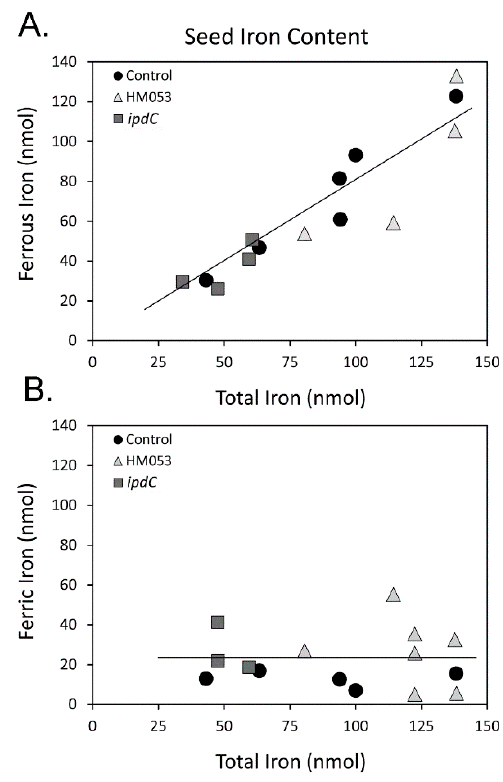
Figure 5. Seed iron content as total iron, ferric iron, and ferrous iron as a function of treatment type. Panel A: data on seed ferrous (Fe 2+ ) concentration relative to total iron from the 2018 harvest. There was a positive correlation across all treatment types between ferrous iron and total iron content in maize seed. Panel B: data on seed ferric iron (Fe 3+ ) concentration relative to the total iron. There is no strong correlation between changing total iron content and ferric iron in maize seed kernels.